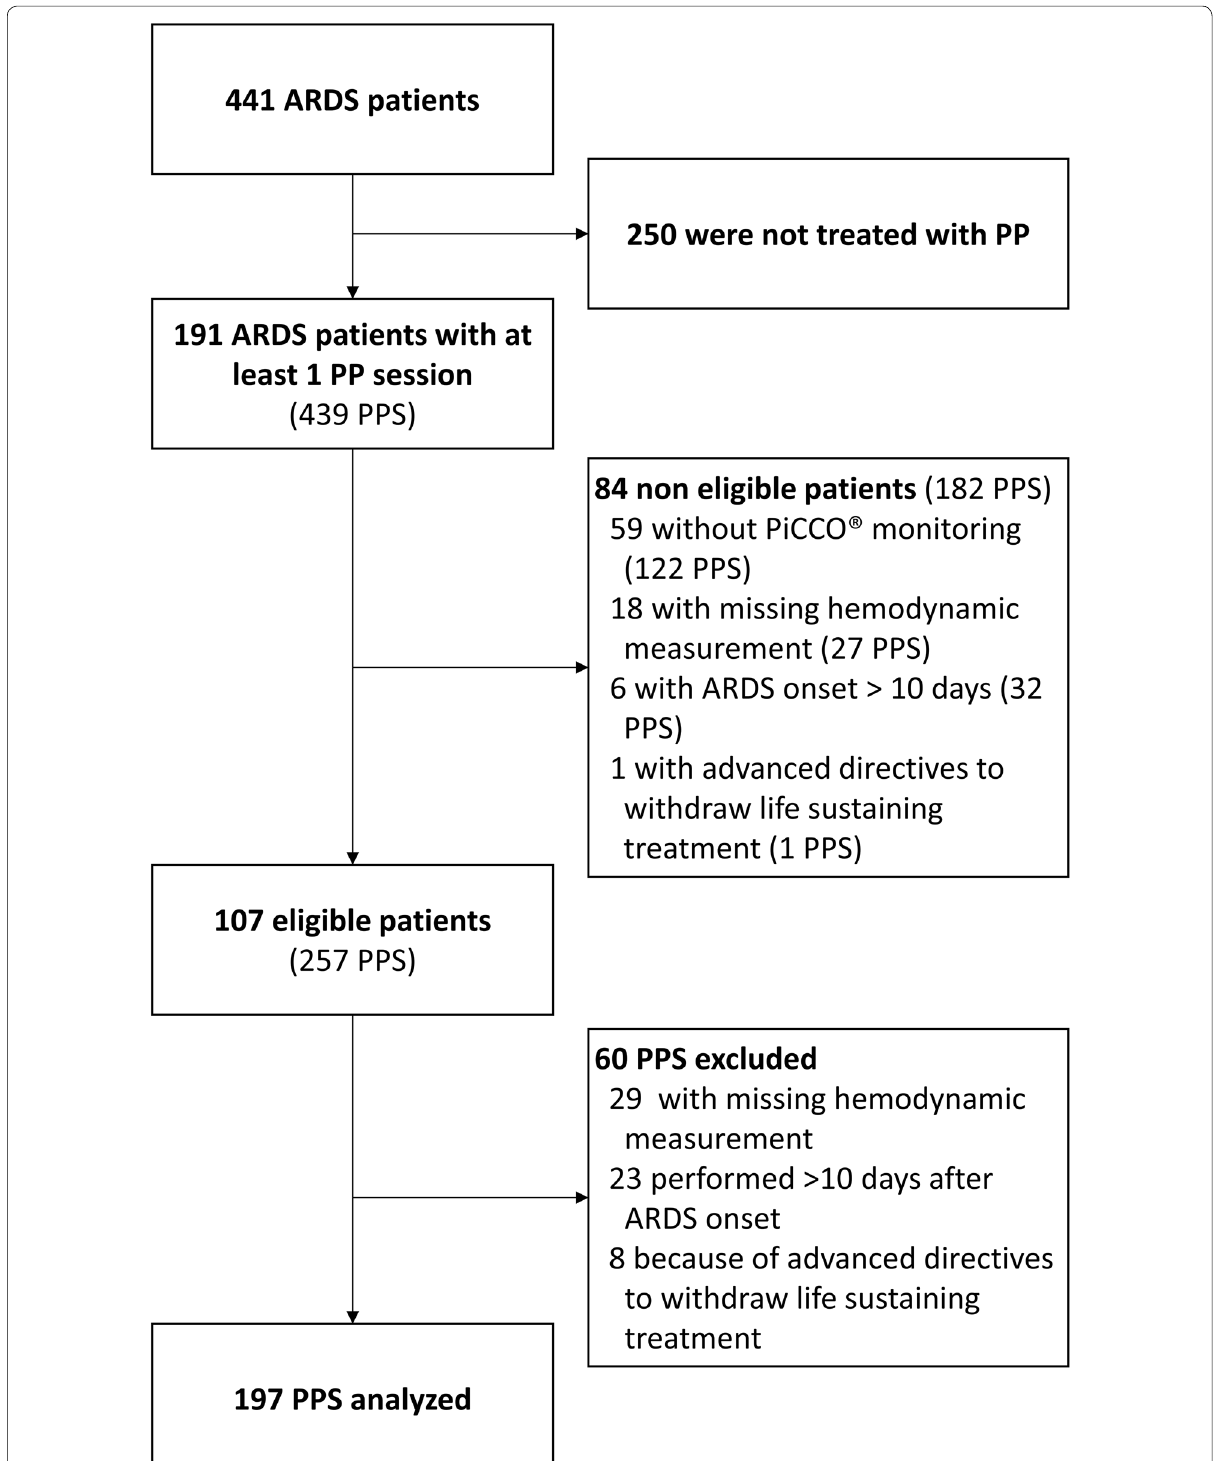
Fig. 1 Study flowchart. ARDS acute respiratory distress syndrome, PPS prone positioning